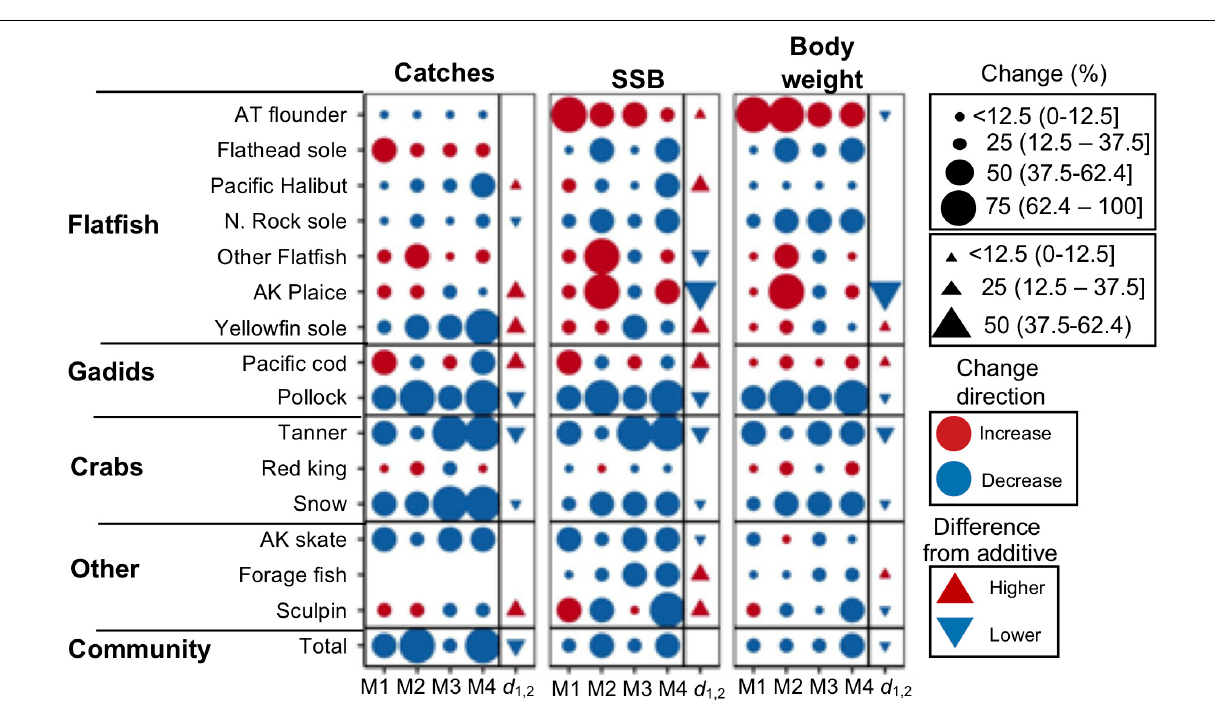
FIGURE 6 | Mean projected changes in 2090 catches, SSB, and mean body size under RCP 8.5 and assuming status quo fishing for MSSM variants that assume the following temperature-dependencies on biological rates: none (M1), body growth-related rates (M2), intrinsic natural mortality (M3), and intrinsic natural mortality and body growth-related (M4). Changes are relative to historical average conditions (1995 to 2014). For each species and variable, the cumulative effects ( d 1 , 2 ) of natural mortality and body growth-related temperature-dependencies are provided as the difference from outcomes derived from the assumption that cumulative effects are additive (triangle